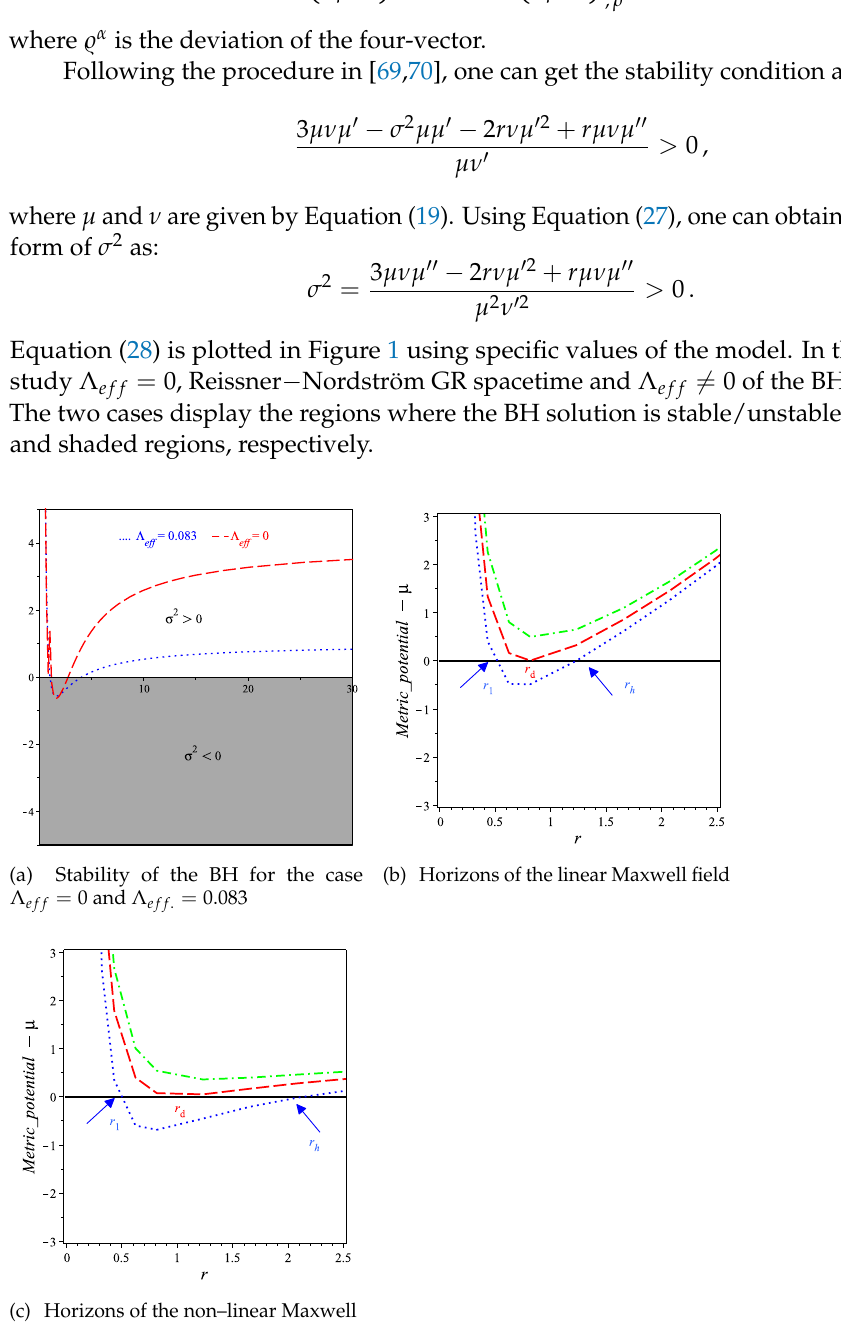
Figure 1. Plot ( a ) shows the behavior of Equation (28) viz r for BH (19). The behavior of the metric potential µ ( r ) , which characterizes the horizons by putting µ ( r ) = 0: ( b ) for linear Maxwell Rastall gravity theory; ( c ) for the nonlinear electrodynamics Rastall’s theory. The values of m for the linear case are 1.3; 0.99; 0.8 and q = 1, while for the nonlinear case m = 1.3; 1.1 and 0.9, q = 1 and Λ ef f . =